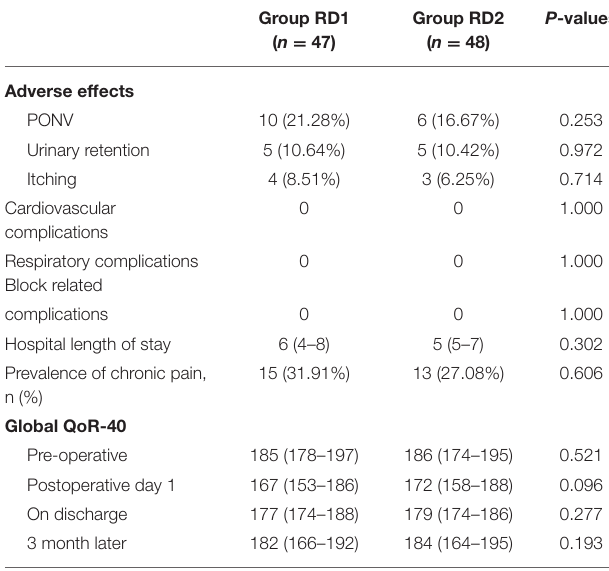
TABLE 5 | Comparison of incidence of adverse effects, hospital length of stay, QoR-40, and prevalence of chronic pain between the two